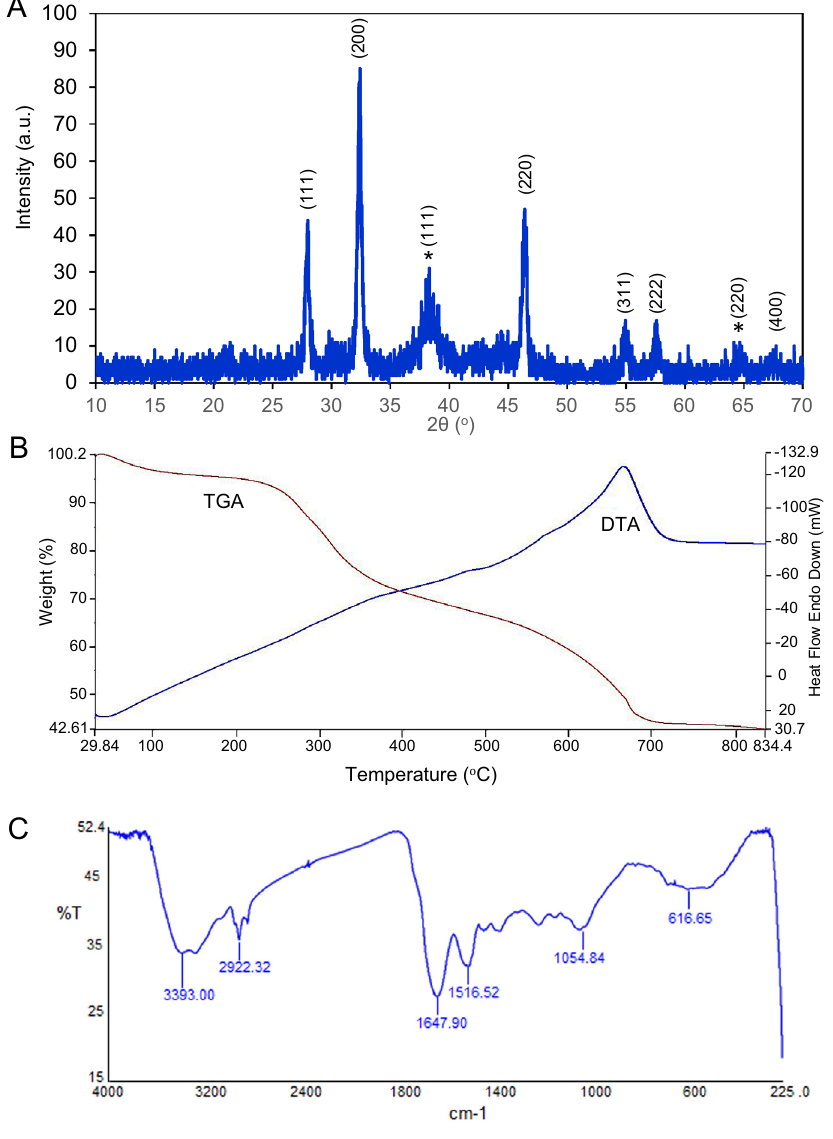
Figure 2. XRD, TGA and FTIR spectrum. ( A ) XRD pattern ( B ) TGA and ( C ) FTIR spectrum of the synthesized